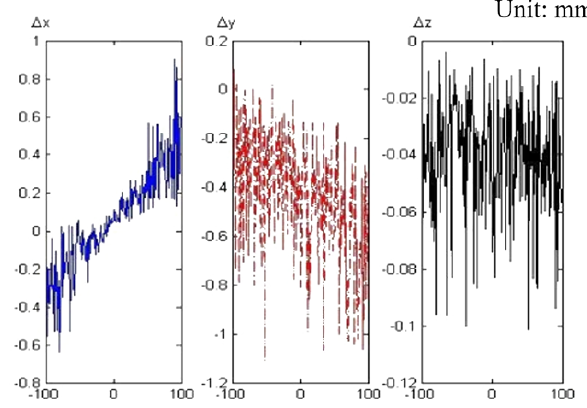
Figure 11. Position error caused by the attitude error when x = 0, z = 1000mm and Y = ( − 100 , 100).